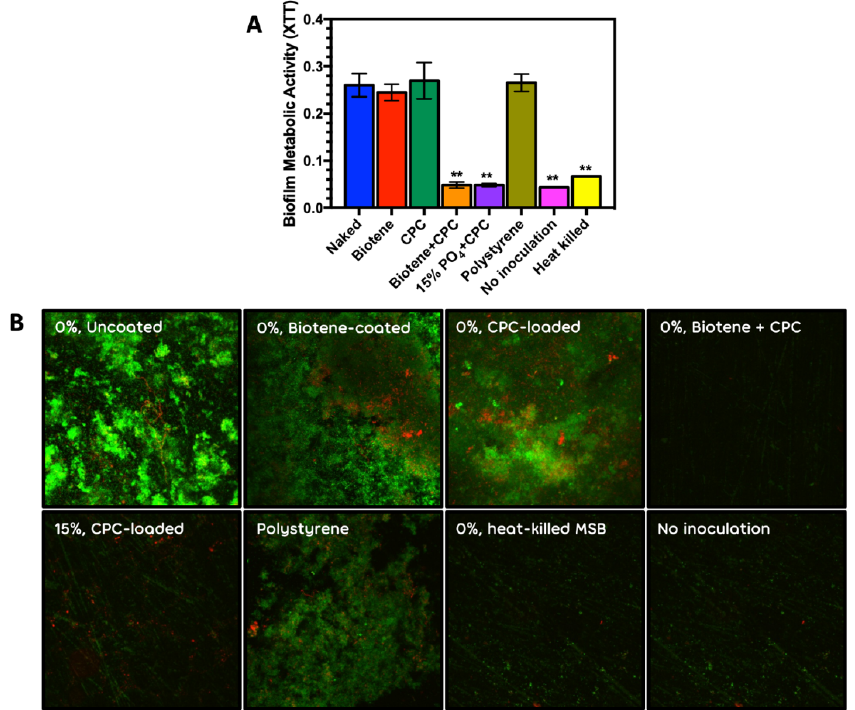
Figure 5. ( A ) Metabolic activity (XTT) average and standard deviations derived from 6 replicate disks and ( B ) Confocal microscopic images of mixed salivary bacterial biofilms on PMMA; 0%, Uncoated, 0%, Biotene PBF-coated, 0%, CPC-loaded, 0%, Biotene PBF + CPC, 15%, CPC-loaded, Polystyrene, 0%, heat-killed MSB and No inoculation. CPC at 350 µg/mL. ** Statistically significant reduction in metabolic activity compared to PMMA control (0% Phosphate).